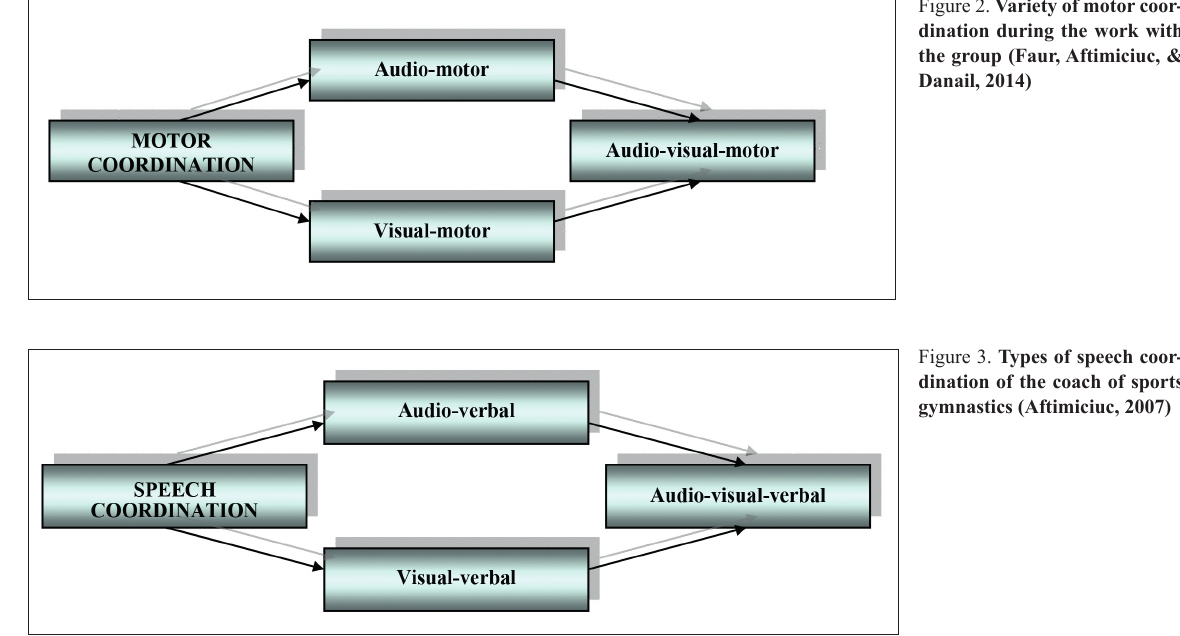
Figure 2. Variety of motor coor- dination during the work with the group ( Faur, Aftimiciuc, & Danail, 2014)